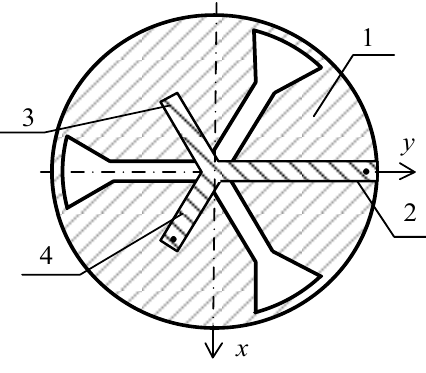
Fig. 1. Radiating structure arrangement.